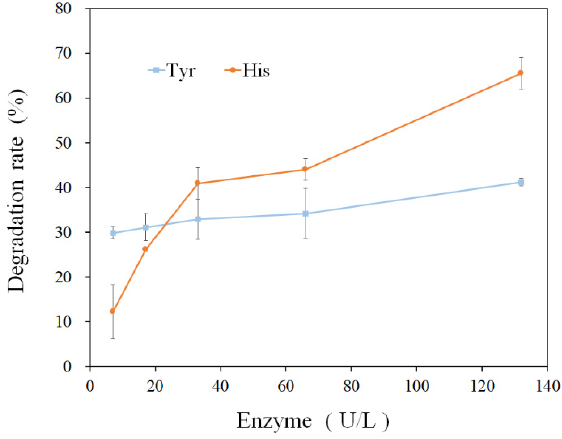
Figure 5. Histamine and tyramine degradation rates of rMCO.